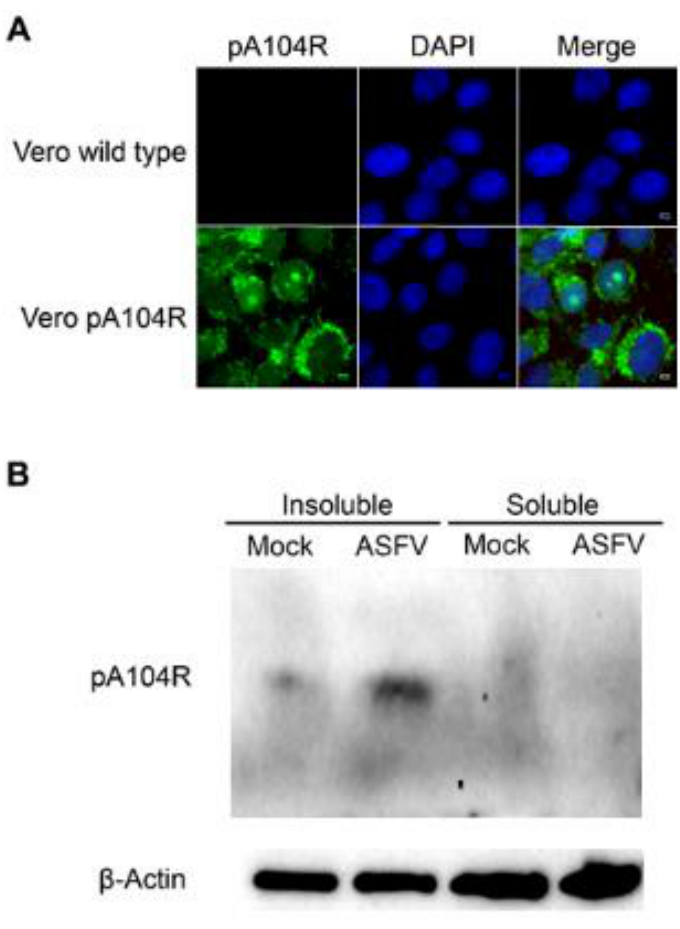
Figure 5. Helper Vero cells expressing viral pA104R. ( A ) Immunofluorescence studies detected African swine fever virus (ASFV)-pA104R in the cytoplasm and nucleus of Vero-pA104R cells. pA104R and DAPI (4′,6-diamidino-2-phenylindole) staining is shown in green and blue, respectively. ( B ) Transformed Vero cells non-infected and infected with Ba71V isolate (multiplicities of infection (MOI) = 2; 18 h post infection (hpi)) were re-suspended into buffer containing 0.1% Tx-100 and fractionated. pA104R was only detected in the Triton X-100-insoluble fraction, as expected, both in non-infected and infected transfected cells. β-actin was used as loading control.